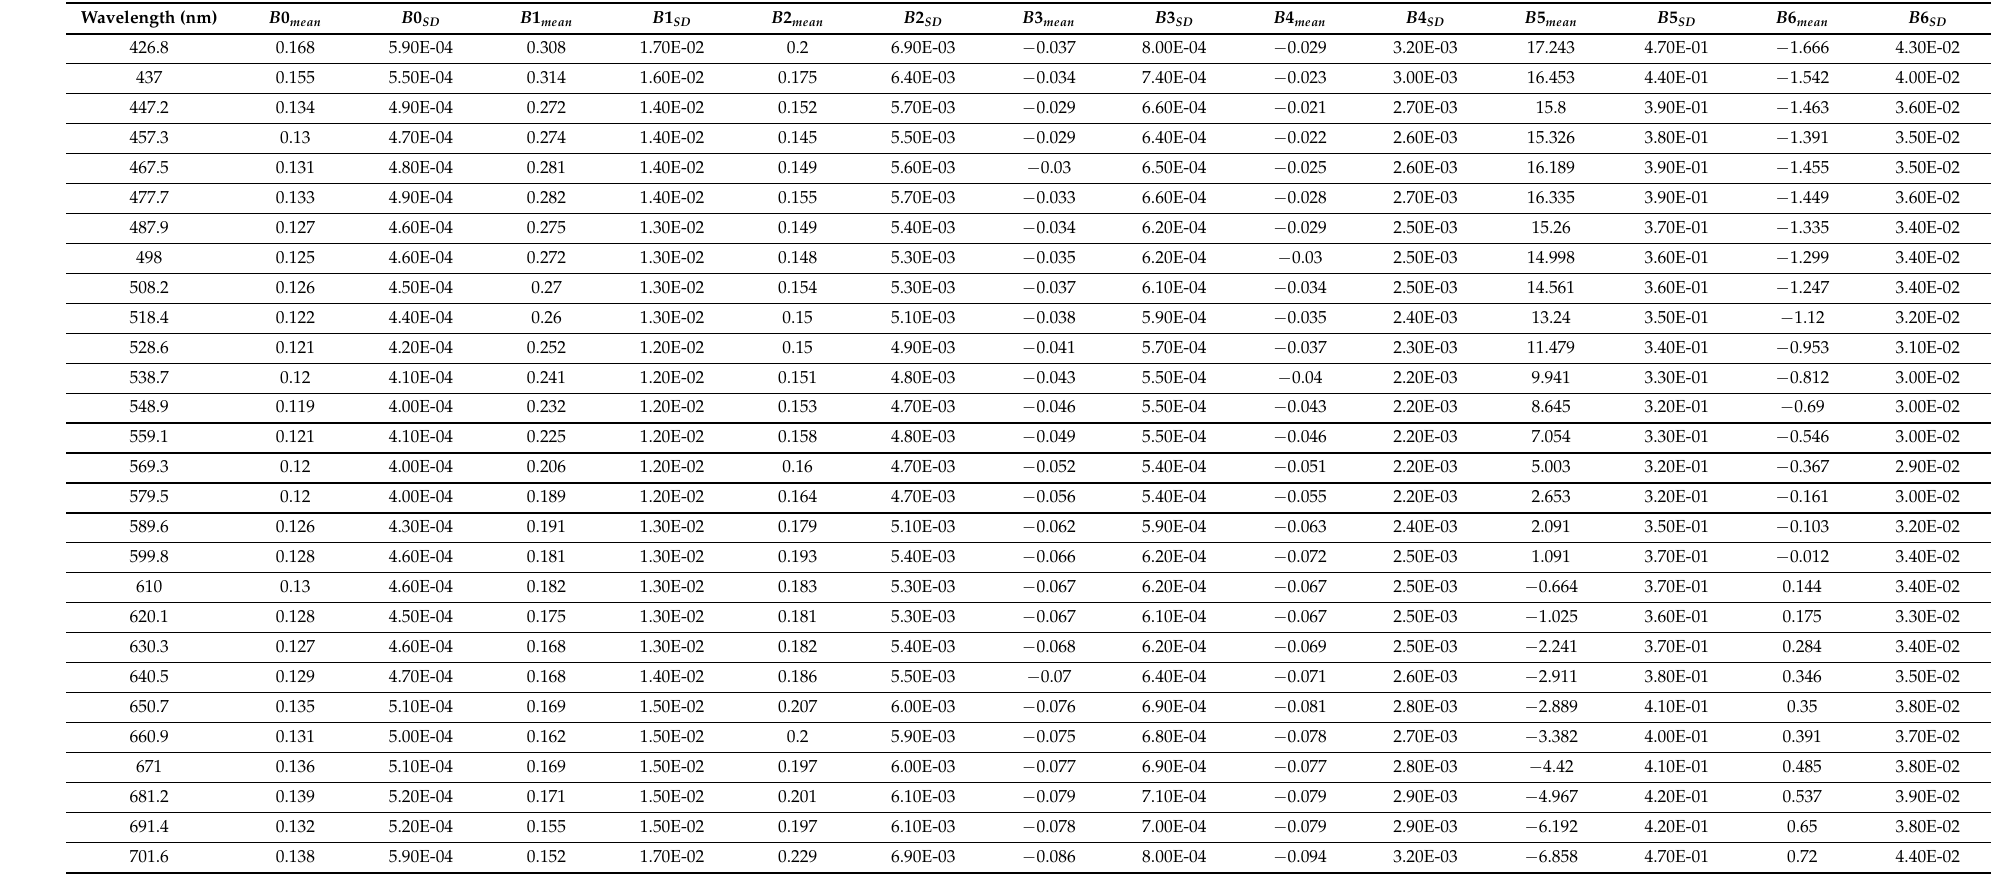
Table A1. Showing the initial distribution of the mean and standard deviation of the DAHAC model’s coefficients for 196